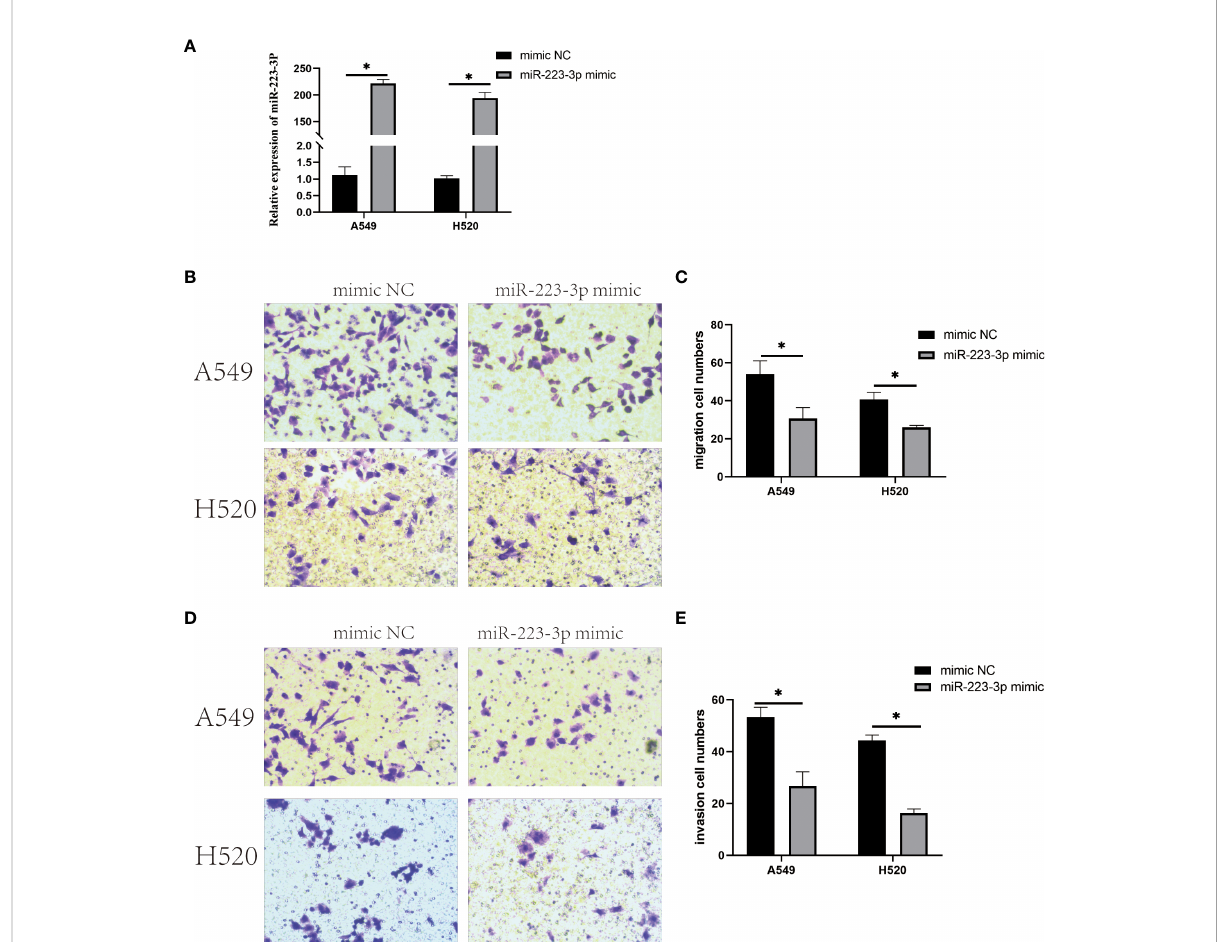
FIGURE 4 Overexpression of miR-223-3p inhibited the migration and invasion of A549 and H520 cells. (A) The relative expression of miR-223-3p in miR- 223-3p mimic group was detected by qRT-PCR. (B) Cells at the bottom of the fi lter membrane without Matrigel matrix glue were measured in high vision fi eld (200x). (C) Quantitative analysis of the migration cells of A549 and H520 were measured. (D) Cells at the bottom of the fi lter membrane with Matrigel matrix glue were detected in high vision fi eld (200x). (E) Quantitative analysis of the invasion cells of A549 and H520 were measured. Data were presented as means ± SD of three independent experiments. * P